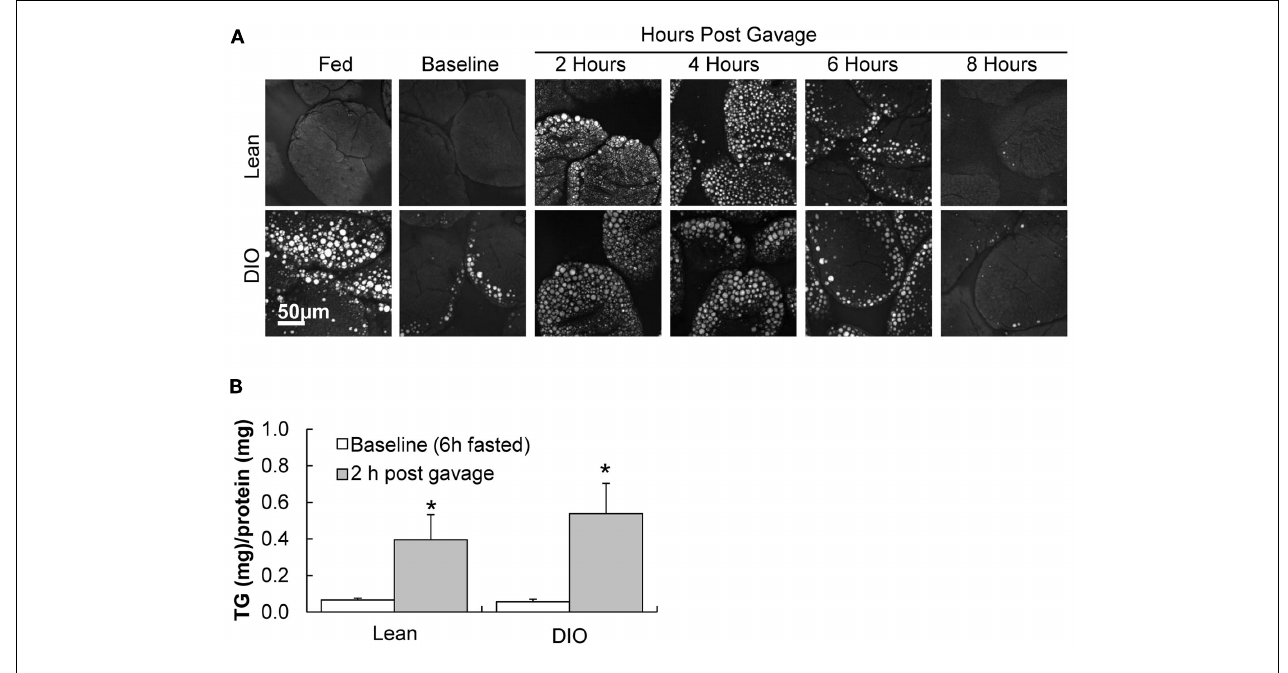
duodenum of lean and DIO mice (6weeks of HF feeding) at baseline (6h fast) and 2h post oil bolus. Data are represented as mean ± SEM. Asterisks denote significant differences inTG concentration between baseline and 2h post oil bolus of respective groups (Two-way ANOVA, Tukey post hoc test), P < 0.05, n = 4 mice.